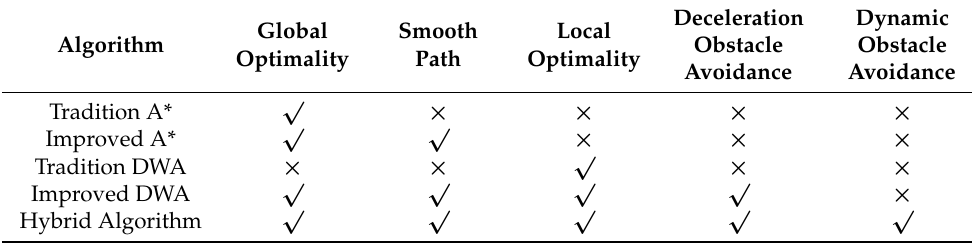
Figure 15. Dynamic path planning algorithm for FAGV returns a global path after avoiding static obstacles. ( a ) FAGV detects a static obstacle that is about to collide. ( b ) FAGV returns to the global path after avoiding static obstacles.